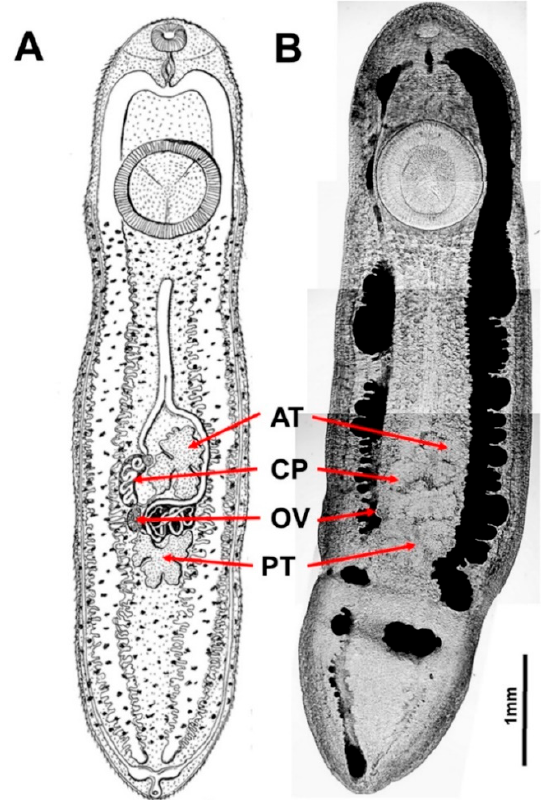
Figure 1. Ventral view on metacercariae of Clinostomum chabaudi. (A) Modified schematic drawing from Vercammen-Grandjean (1960) [11]. (B) Photograph of a fully grown, live metacercaria infesting the dorsal lymphatic sac of a H. viridiflavus male in March 2017. Scale bar = 1 mm. Genital complex, abbreviations: AT = anterior testis, CP = cirrus pouch, OV = ovary, PT = posterior testis. Principal Component Analysis (PCA) based on 10 morphometric distances